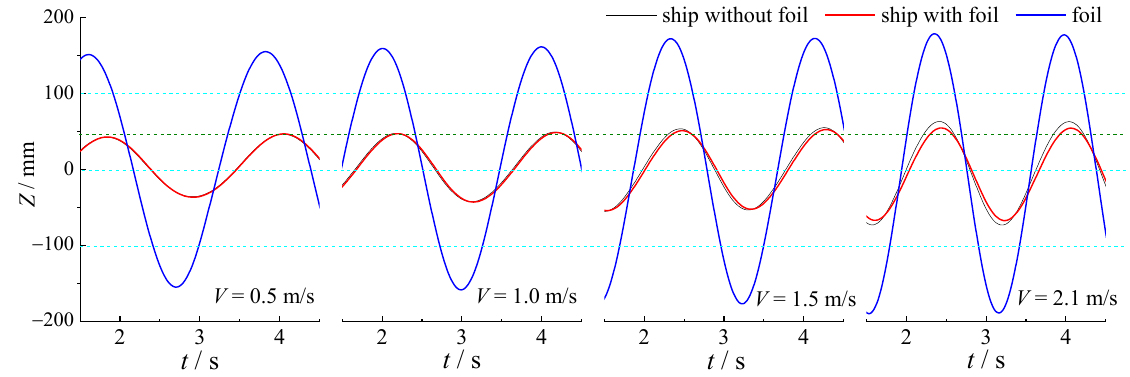
Figure 11. Heaving motion time – history curves of the hull and bow foil in head waves (black line: normal hull without bow foil; red line: hull with bow foil; blue line: rotation axis of bow foil).